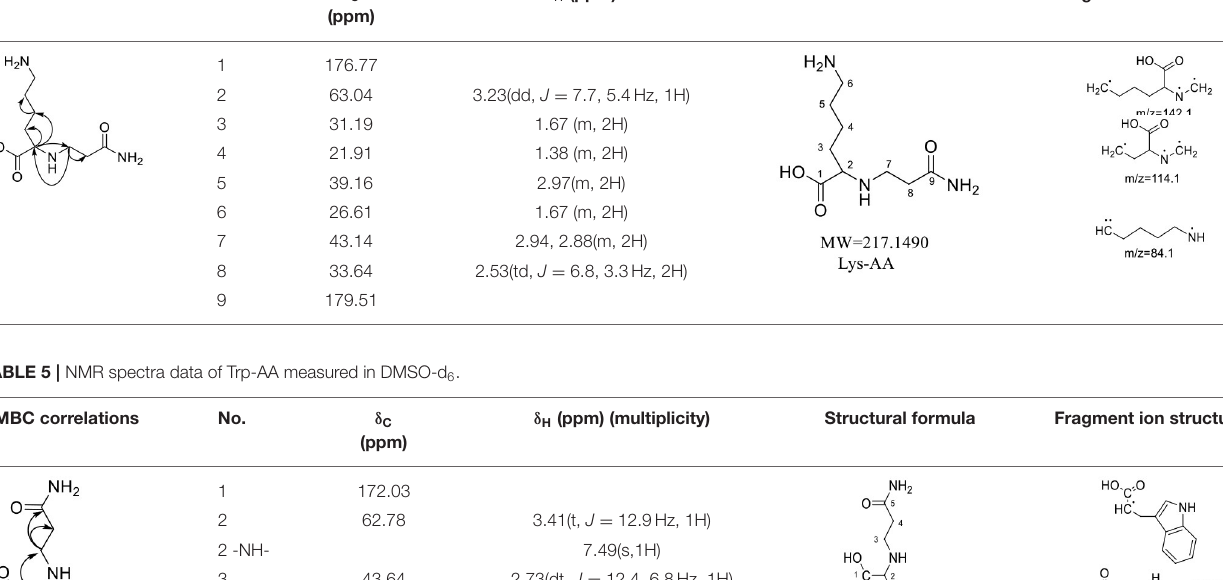
TABLE 4 | NMR spectra data of Lys-AA measured in D 2 O. HMBC Correlations